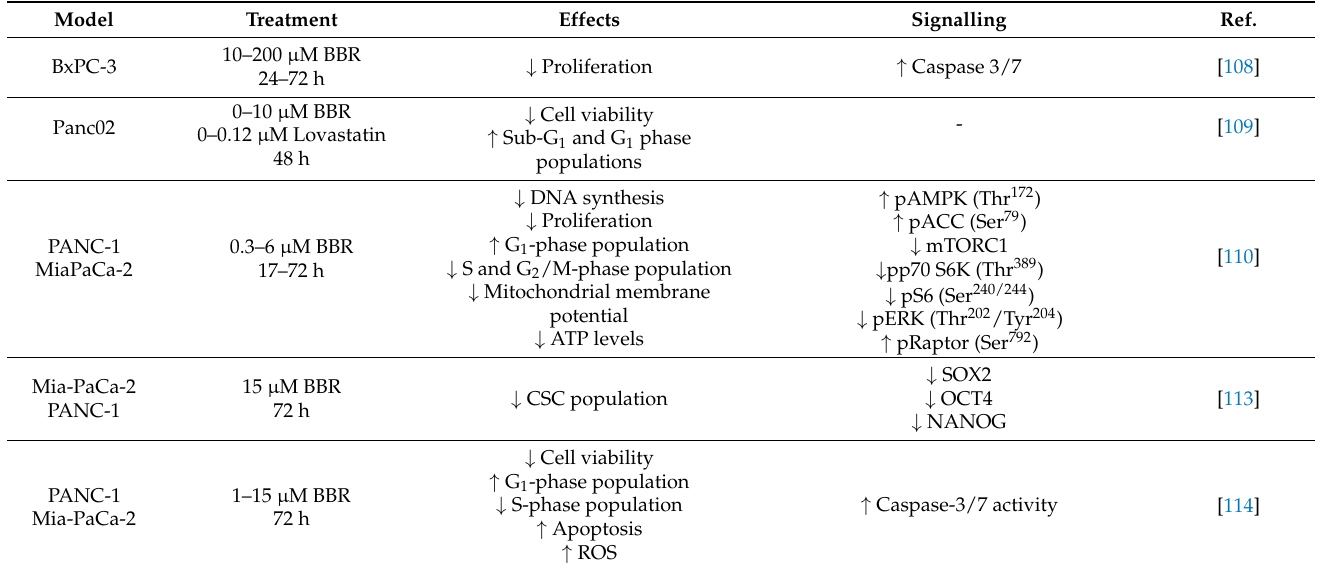
Table 2. Effects of BBR against pancreatic cancer in